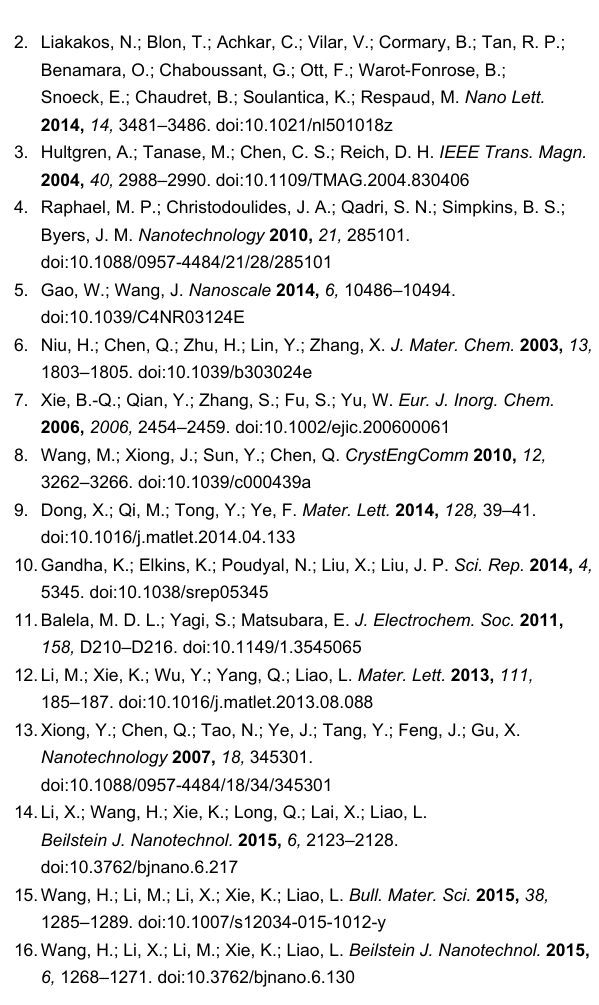
Figure 4: The hysteresis loop of the PVP-protected cobalt nanowires prepared under an external magnetic field measured at room temperature. The inset shows the respective expanded plots for fields between − 6000 and 6000 Oe.